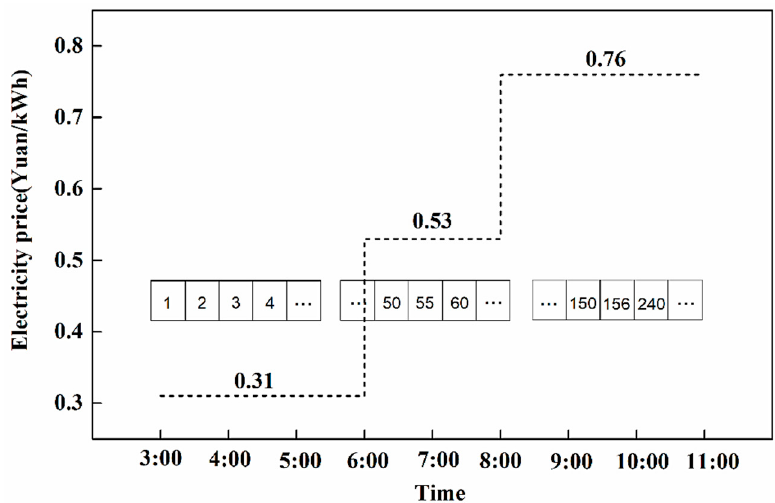
Figure 5. Schematic diagram of production scheduling under time-of-use (TOU) electricity pricing.